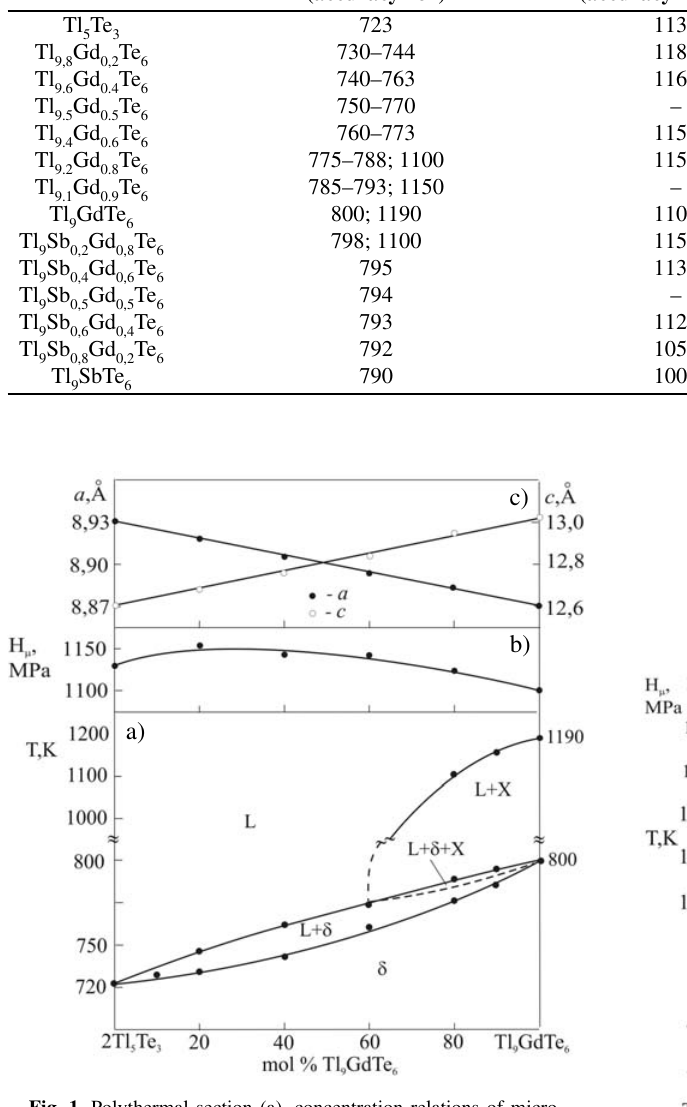
Fig. 1. Polythermal section (a), concentration relations of micro- hardnesses (b), and lattice parameters (c) for the system 2Tl Tl GdTe 9 6